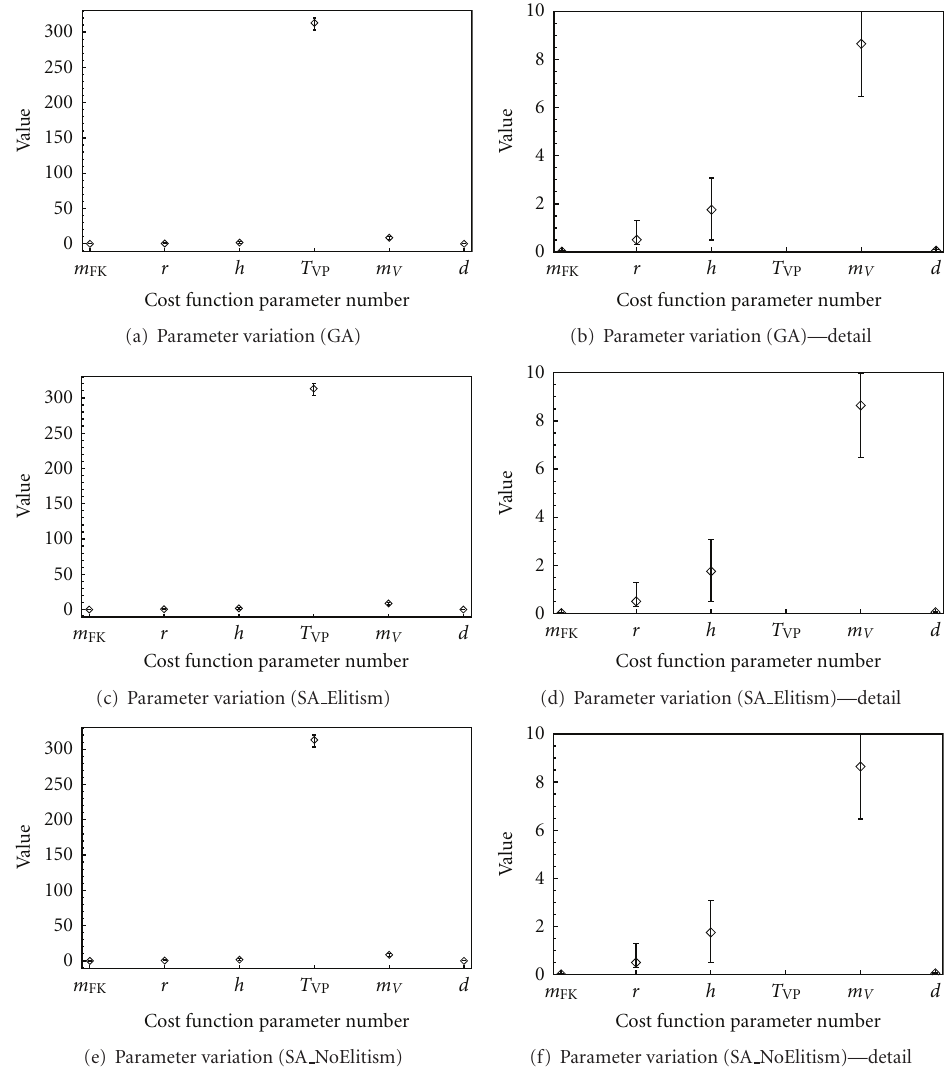
Figure 4: Parameter variation of GA and